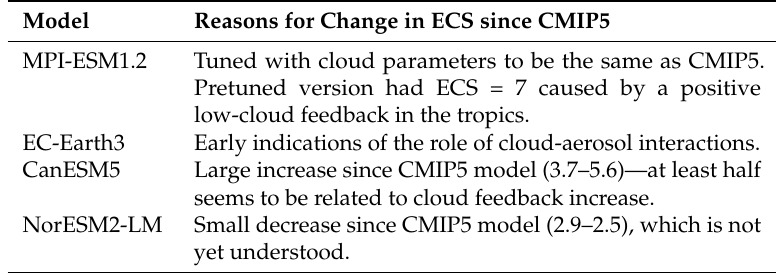
Table 1. Possible reasons for the differences in ECS between the CMIP5 and CMIP6 models studied here according to [11]. Model Reasons for Change in ECS since CMIP5 MPI-ESM1.2 Tuned with cloud parameters to be the same as CMIP5. Pretuned version had ECS = 7 caused by a positive low-cloud feedback in the tropics. EC-Earth3 Early indications of the role of cloud-aerosol interactions. CanESM5 Large increase since CMIP5 model (3.7–5.6)—at least half seems to be related to cloud feedback increase. NorESM2-LM Small decrease since CMIP5 model (2.9–2.5), which is not yet